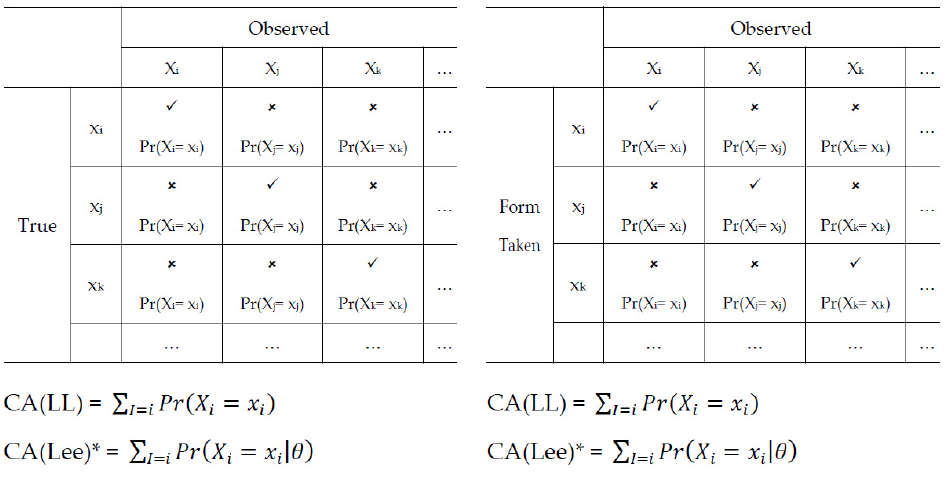
Figure 1. An example showing the CA and CC indices by Livingston and Lewis, and Lee, respectively. * The probabilities of each response pattern in the Lee approach are computed as a given θ .